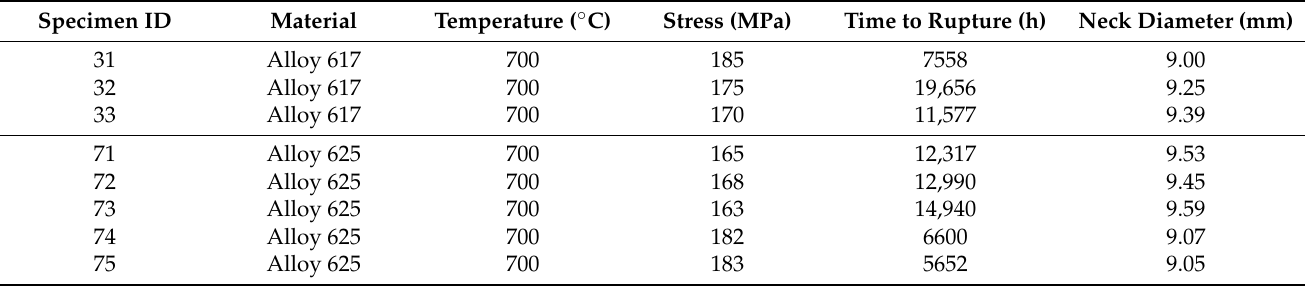
Table 2. Creep test